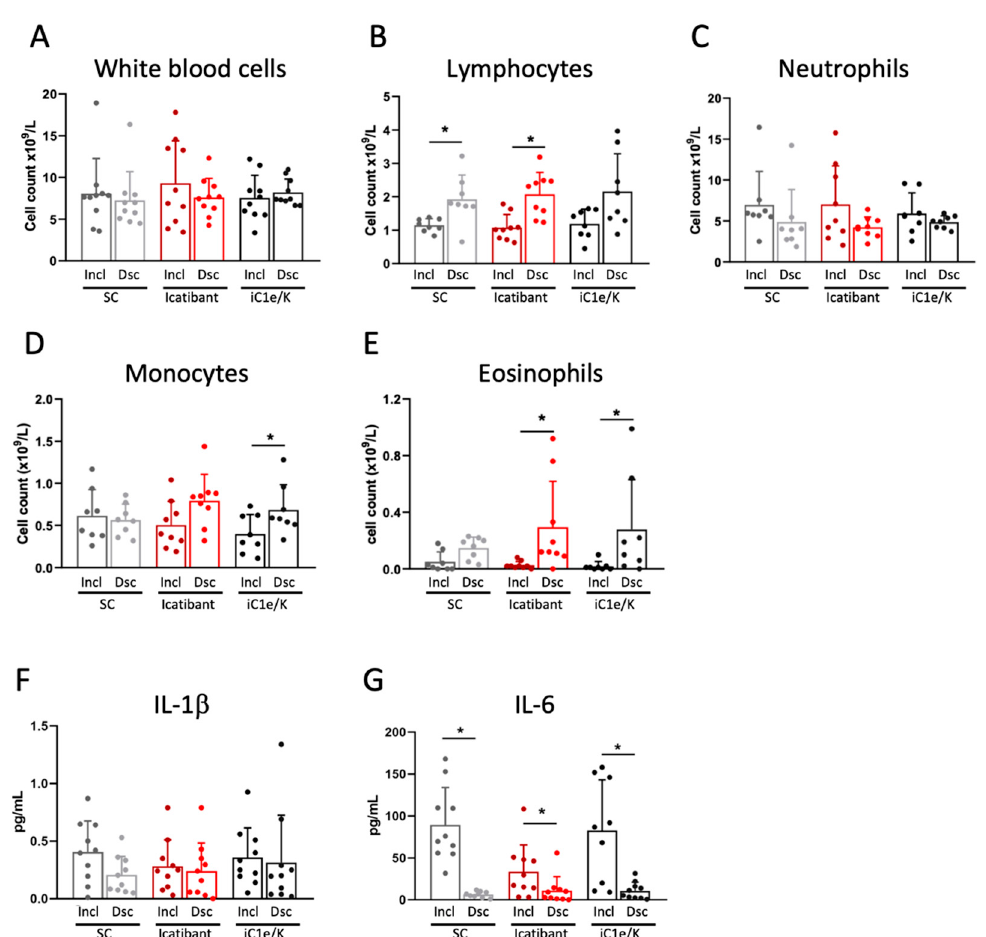
Figure 3. Blood immune cell and cytokine outcomes. White blood cells ( A ), lymphocytes ( B ), neutrophils ( C ), monocytes